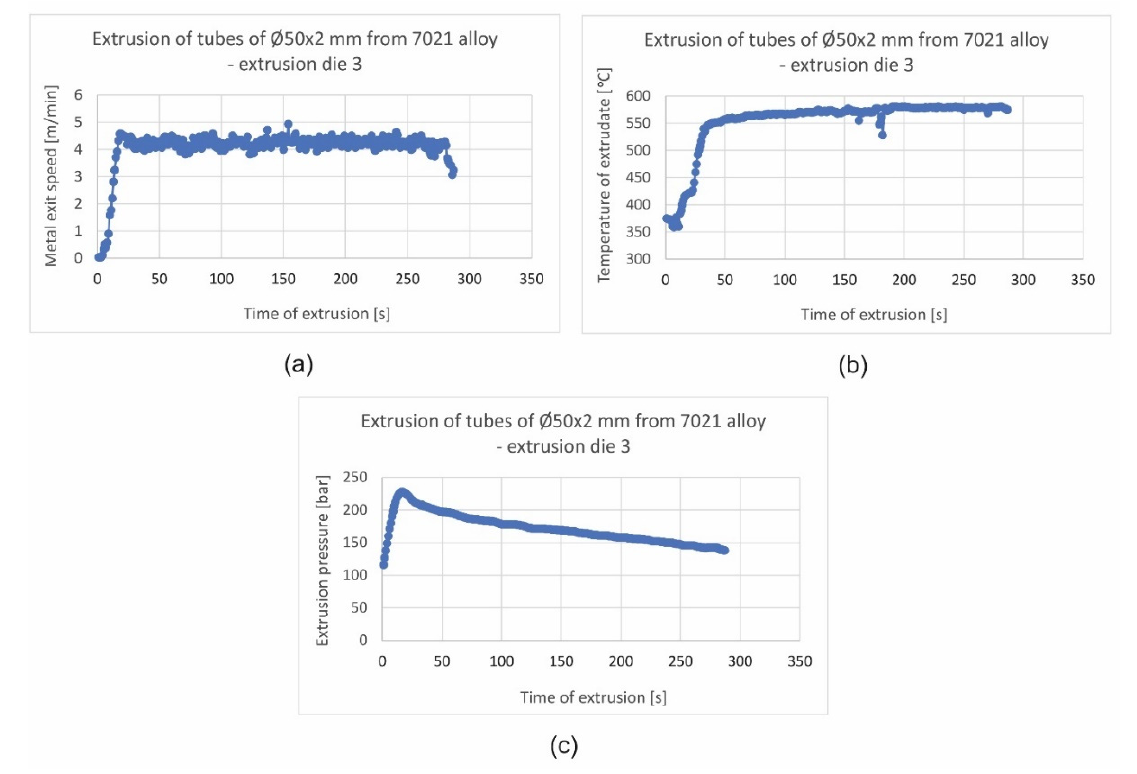
Figure 14. Recorded technological parameters of extrusion of tubes of Ø50 × 2 mm from 7021 alloy for extrusion die 3: metal exit speed ( a ), extrudates temperature ( b ) and extrusion pressure ( c ).